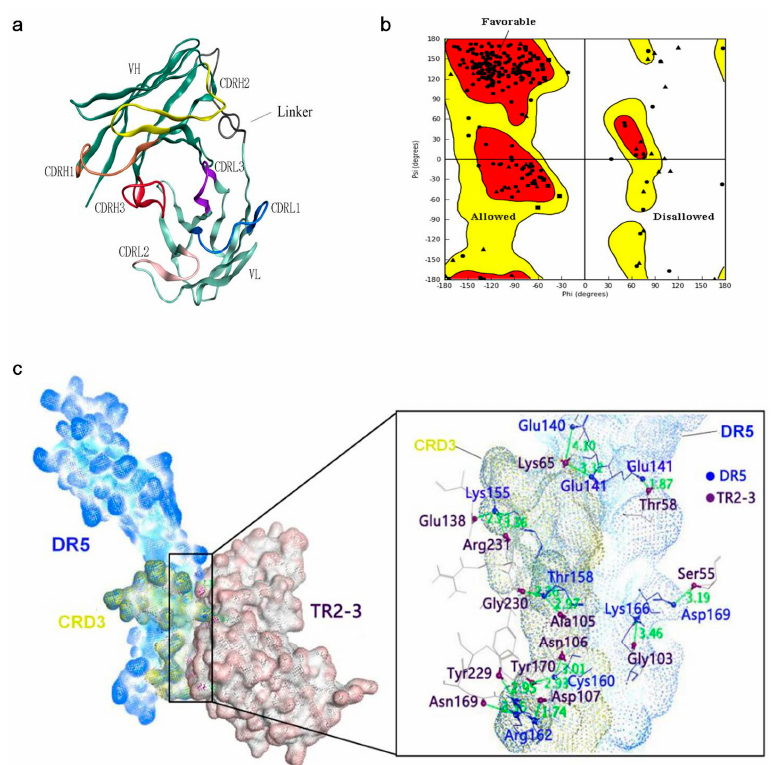
Figure 5. Structural model of the TR2-3 and DR5 complex by homology modeling and molecular dynamics simulations. ( a ) Three-dimensional model of TR2-3 established by homology modeling; ( b ) Ramachandran plot evaluated the reliability of TR2-3 structure; ( c ) The best conformation of TR2-3 and DR5 complex was obtained with the molecular docking analysis and the close-up view of the TR2-3 and DR5 contacts. The residues of DR5 and TR2-3 was colored in blue and violet respectively. These data are representative of at least three independent experiments.